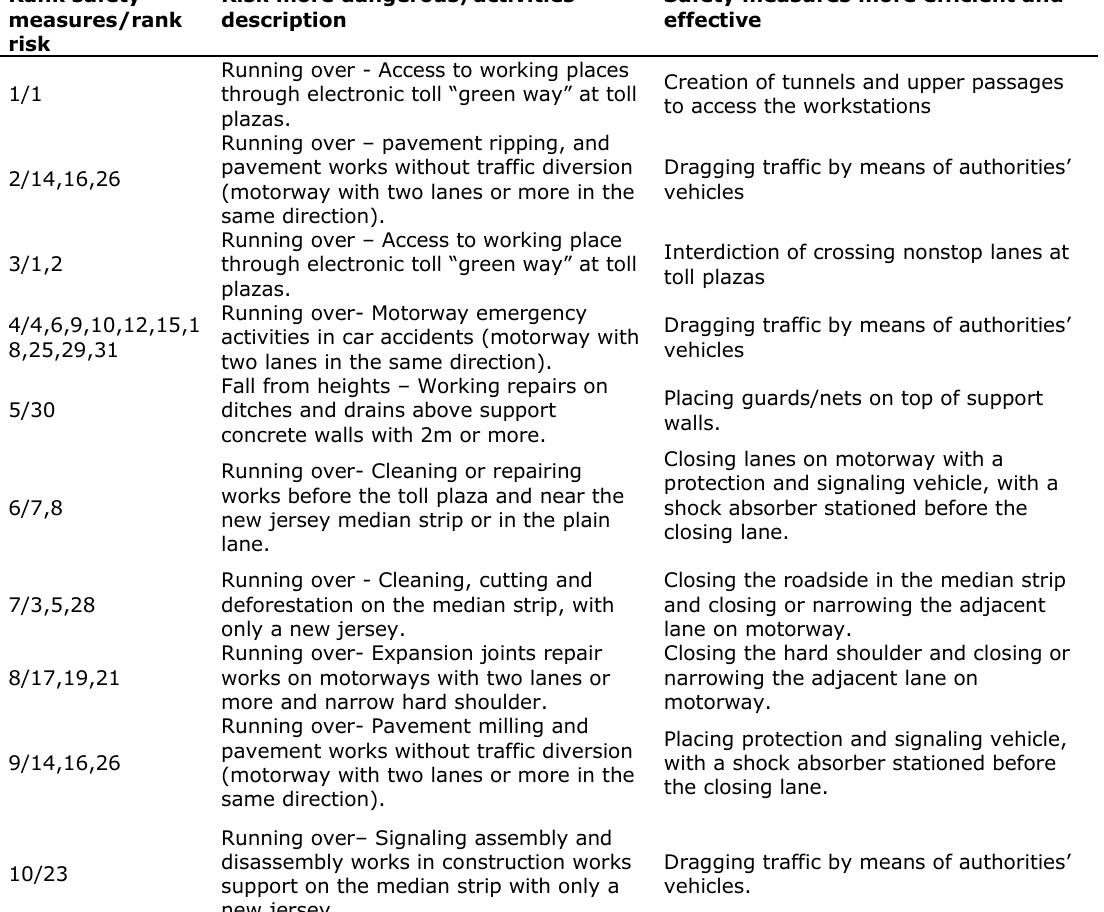
Table 1. Risks and safety measures hierarchy and relationship